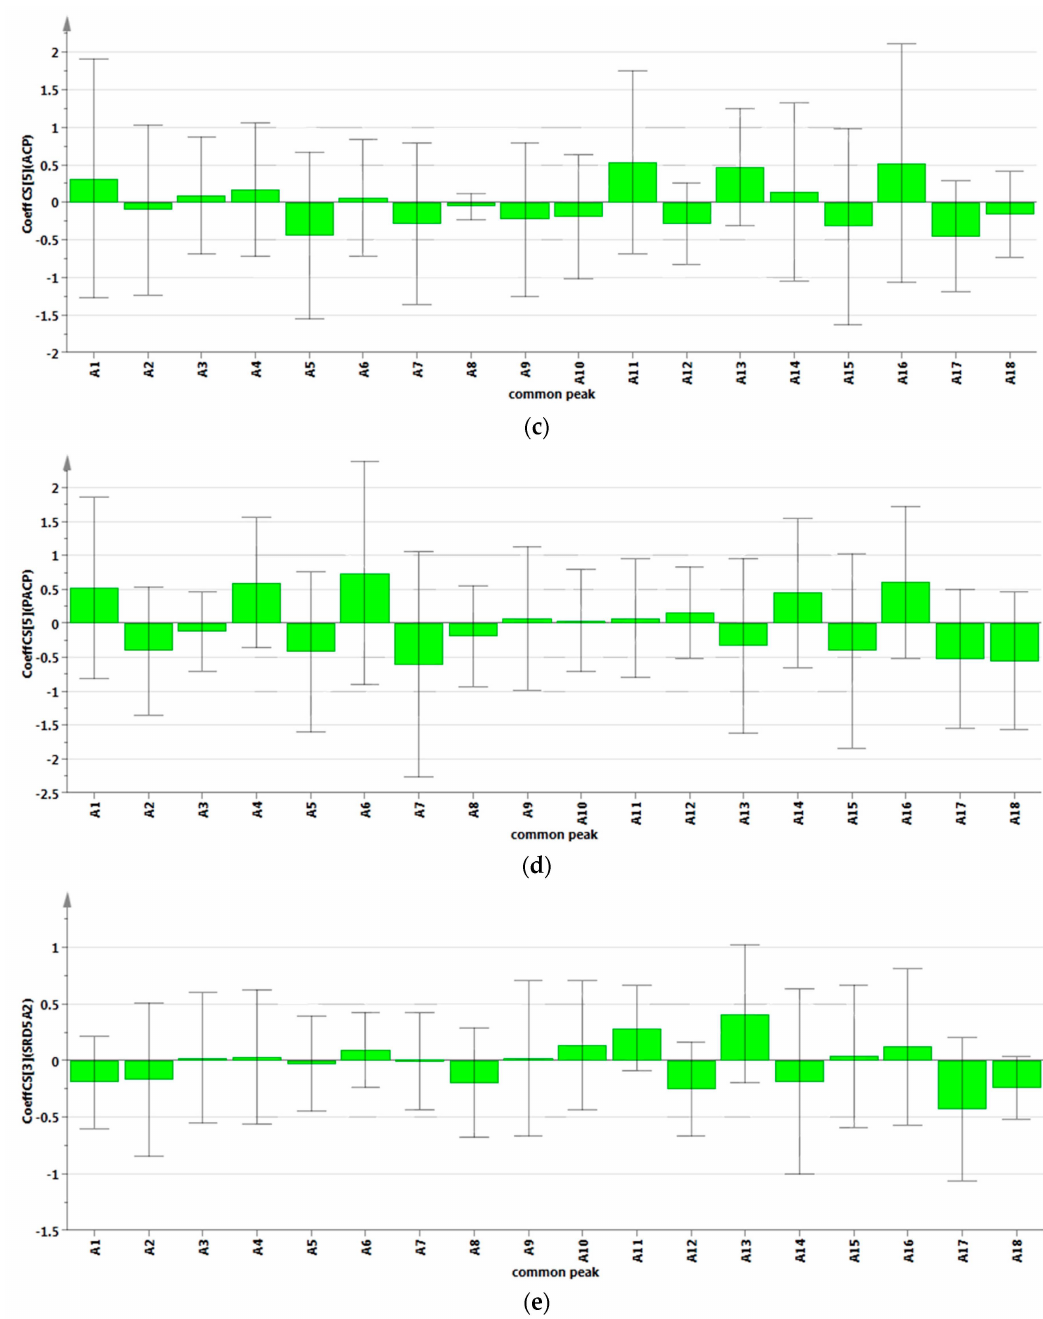
Figure 3. Regression coefficient figure of the 18 compounds and the five indicates about benign prostatic hyperplasia. ( a ) is the regression coefficient figure of PI and the 18 compounds; ( b ) is the regression coefficient figure of DHT and the 18 compounds; ( c ) is the regression coefficient figure of ACP and the 18 compounds; ( d ) is the regression coefficient figure of PACP and the 18 compounds; ( e ) is the regression coefficient figure of SRD5A2 and the 18